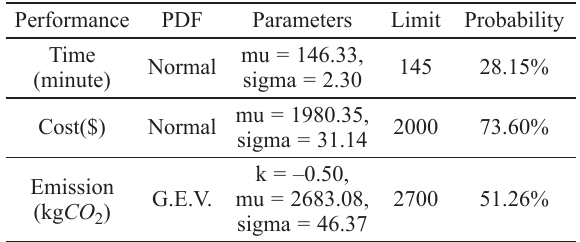
Table 4. Experimental results obtained using SCE 2 Performance